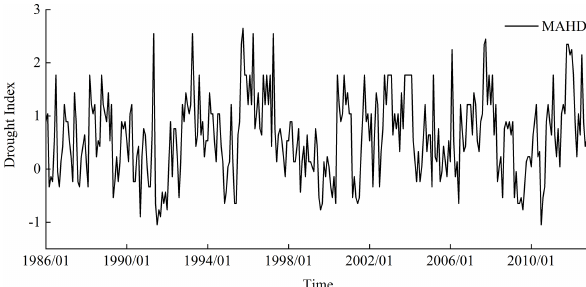
Figure 5. Monthly scale MAHDI sequence at subbasin no.